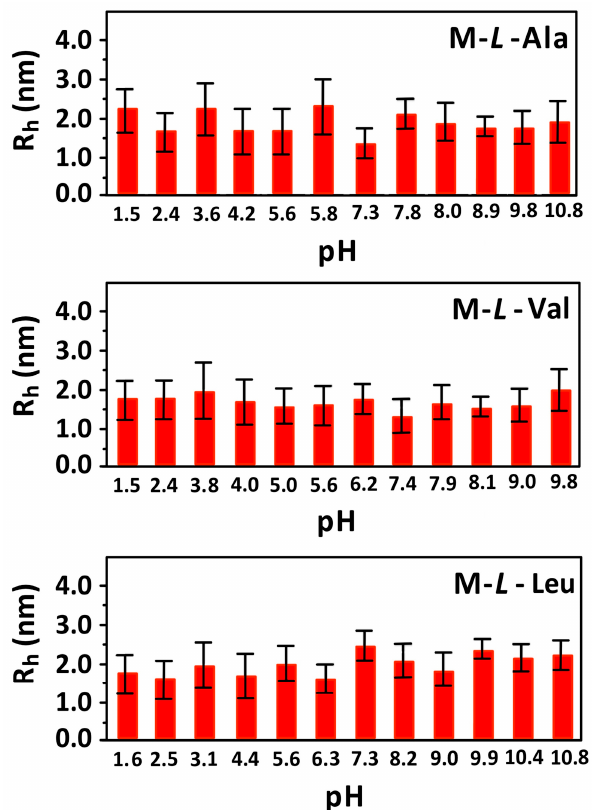
Figure 6. pH Dependence of PAAC hydrodynamic radius from DLS at 25 °C in 0.1 M aqueous NaCl. Polymer concentration 1 mg mL − 1 .